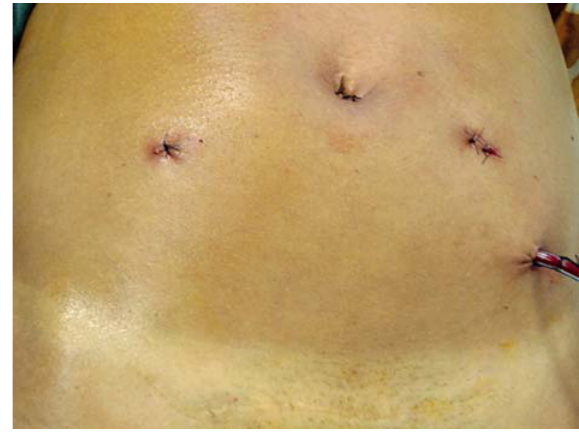
Figure 2 – Immediate postoperative abdominal view of a young female patient after a right laparoscopic uretero-vesical reimplant. A 4 trocar technique was performed with 10 mm trocar for the optic and for the surgeon’s right hand and 2 others for the 5 mm trocars. The suction drain is inserted in the 5 mm left